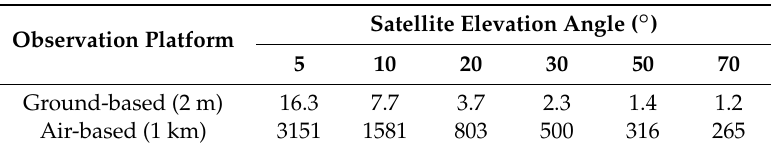
Table 1. Spatial resolutions (m 2 ) of GNSS-R in the B1 band of GPS at different observation platform heights and satellite elevation